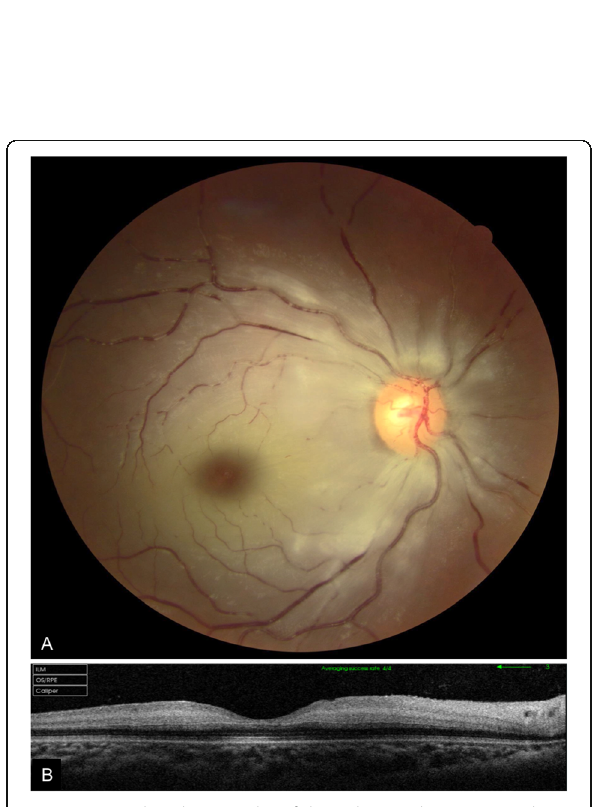
Fig. 3 ( A ) Fundus photography of the right eye showing retinal whitening with a cherry red spot and segmental blood flow consistent with central retinal artery occlusion. ( B ) Swept source OCT scan showing hyperreflectivity of inner retinal layers